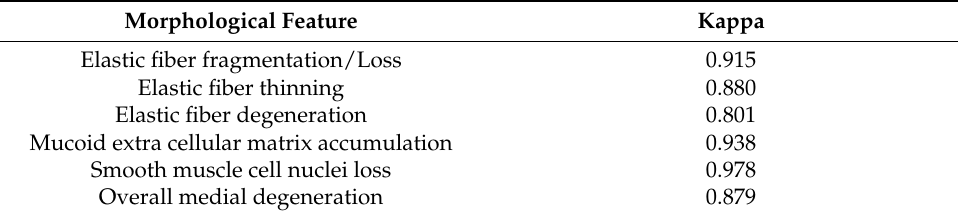
Table 1. Morphological aspects included in the Pathology Consensus Score with the calculated kappa